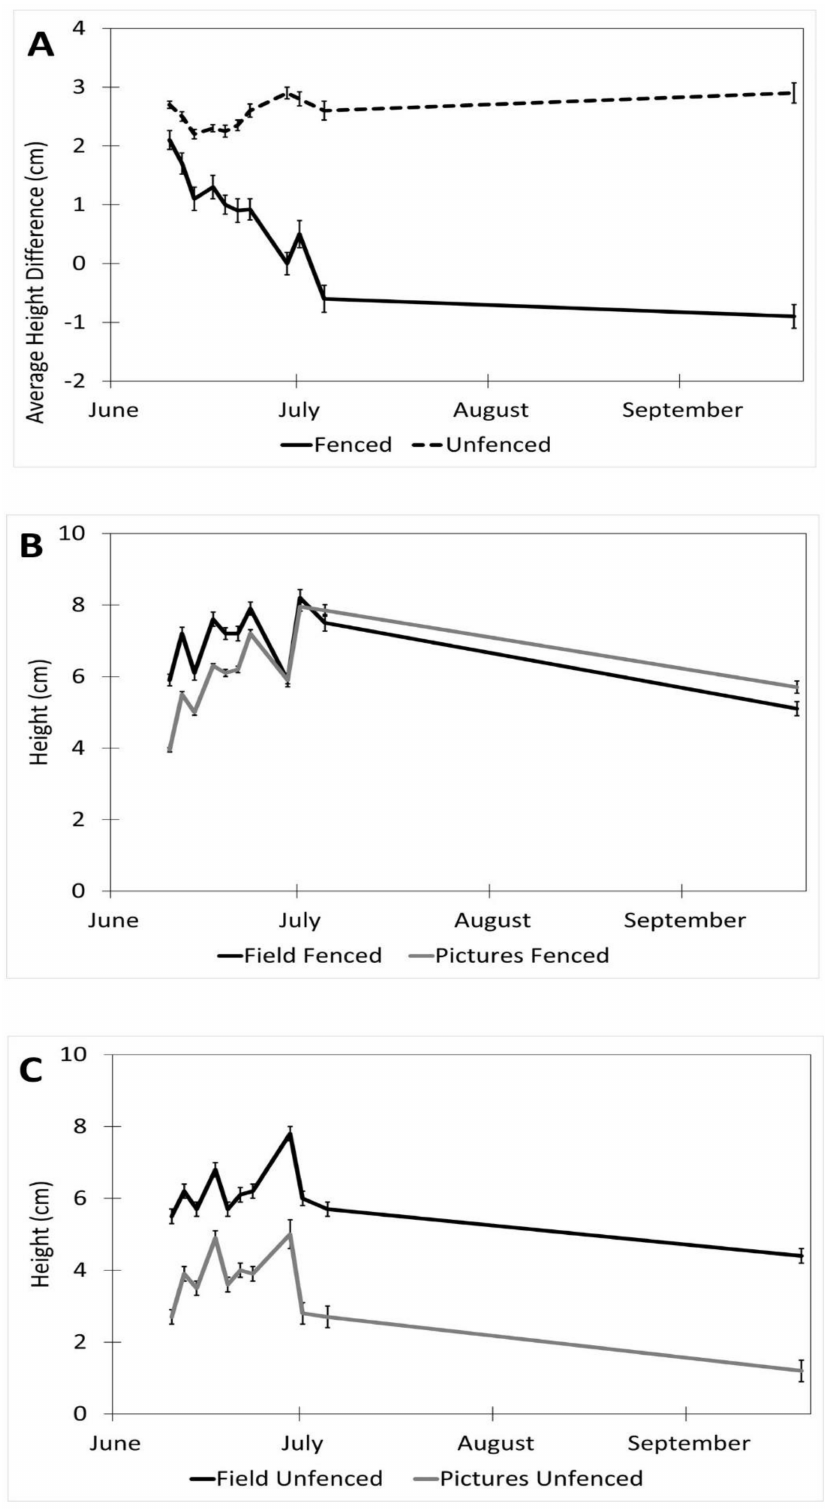
Figure 5. Interaction of date and fencing for height estimates in images vs. field (estimates ± SE). ( A ) Shows the difference in height for fenced vs. unfenced plots (field measurement–image measure- ment). ( B ) A comparison of image and field measurements for height in fenced plots, over time. ( C ) A comparison of image and field measurements for height in unfenced plots, over time. Data were recorded in the field every 2–3 days between 10 June and 5 July 2017, with a final sample collected on 19 September 2017 at the Utah Testing Range,